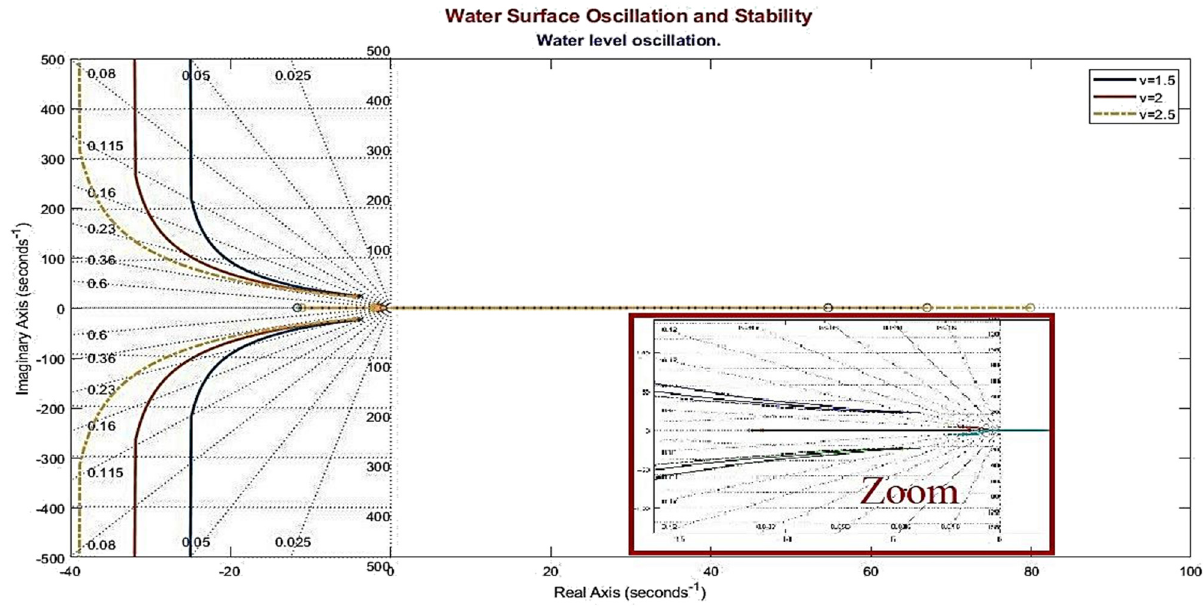
Figure 5: Stability of the system with di ff erent fl ow rate e ff